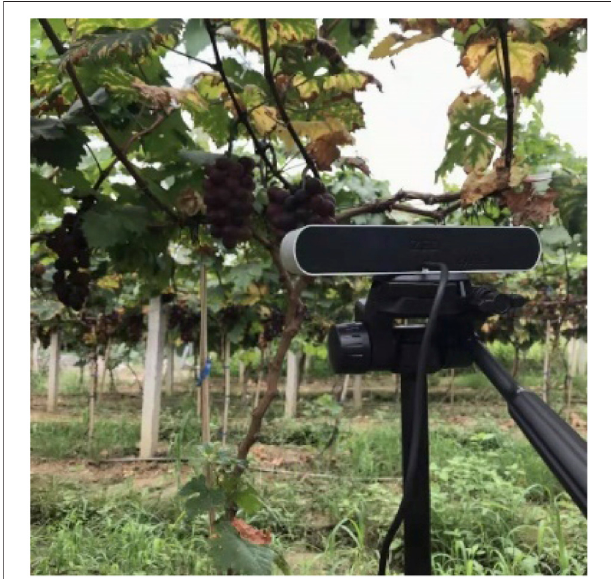
FIGURE 1 | Photograph of the image acquisition